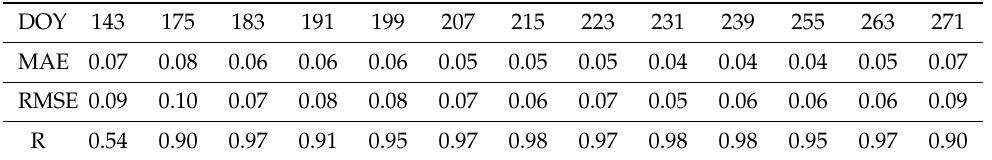
Table 2. Quantitative validation of NDVI for all input days at the CSD